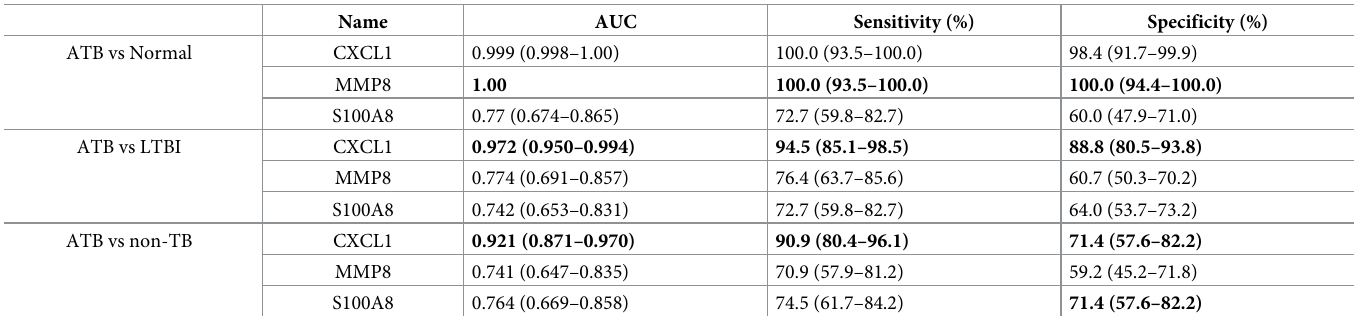
Table 2. Serum protein biomarker AUC analyses in human patient sera. AUC, sensitivity, and specificity values of CXCL1, MMP8, and S100A8 are given for active pul- monary TB (ATB) vs pooled normal, ATB vs latent Mtb infection (LTBI) infection, and ATB vs non-TB comparisons. We denoted the 95% confidence intervals in the parenthesis. For each comparison and each column, the highest value is highlighted in